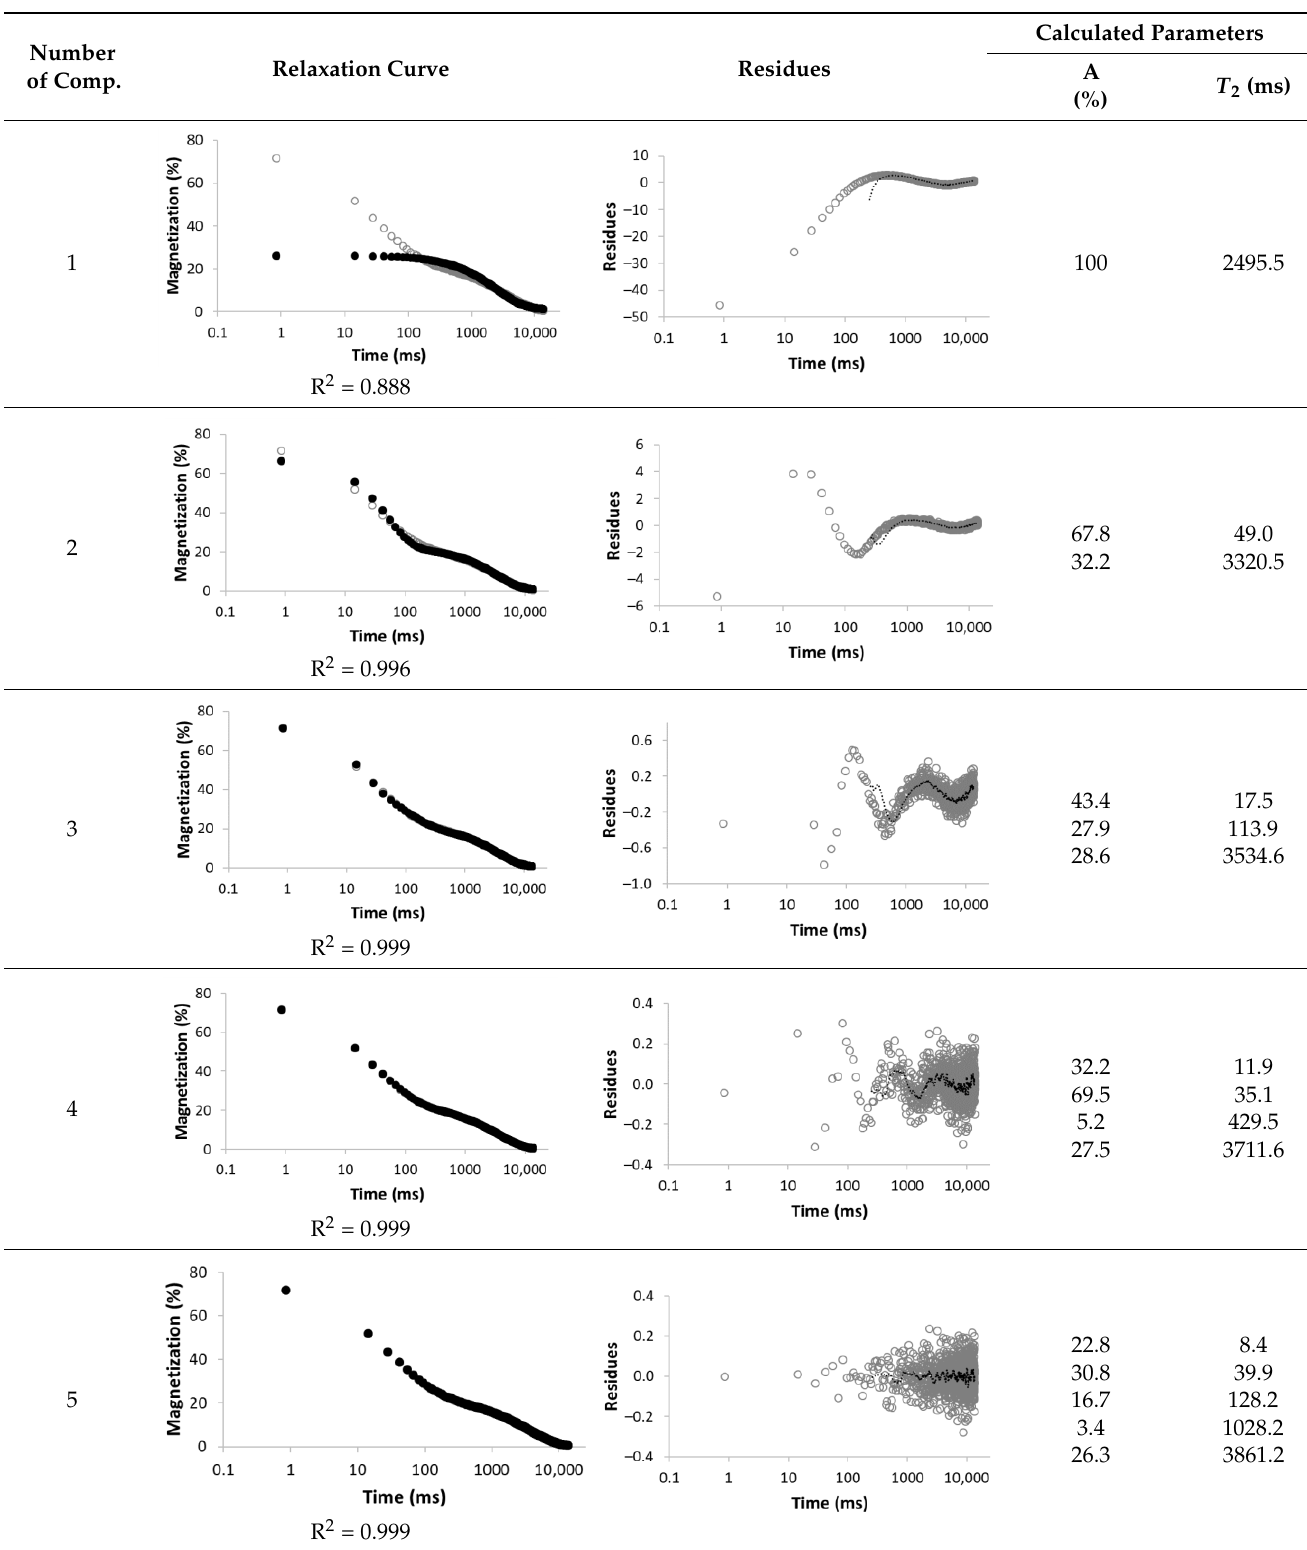
A and relaxation times T 2 , were calculated (Table 3, fourth column). Table 3. Illustration of searching of components number for sample MC-1:6. The experimental Table 3. Illustration of searching of components number for sample MC-1:6. The experimental Table 3. Illustration of searching of components number for sample MC-1:6. The experimental Table 3. Illustration of searching of components number for sample MC-1:6. The experimental Table 3. Illustration of searching of components number for sample MC-1:6. The experimental Table 3. Illustration of searching of components number for sample MC-1:6. The experimental Table 3. Illustration of searching of components number for sample MC-1:6. The experimental Table 3. Illustration of searching of components number for sample MC-1:6. The experimental Table 3. Illustration of searching of components number for sample MC-1:6. The experimental (empty (empty circles) and calculated (solid circles) relaxation curves. Black curve in residues represent (empty circles) and calculated (solid circles) relaxation curves. Black curve in residues represent (empty circles) and calculated (solid circles) relaxation curves. Black curve in residues represent (empty circles) and calculated (solid circles) relaxation curves. Black curve in residues represent (empty circles) and calculated (solid circles) relaxation curves. Black curve in residues represent (empty circles) and calculated (solid circles) relaxation curves. Black curve in residues represent (empty circles) and calculated (solid circles) relaxation curves. Black curve in residues represent (empty circles) and calculated (solid circles) relaxation curves. Black curve in residues represent circles) and calculated (solid circles) relaxation curves. Black curve in residues represent weighed weighed average of residues. weighed average of residues. weighed average of weighed average of residues. weighed average of residues. weighed average of residues. weighed average of residues. weighed average of residues. average of residues.